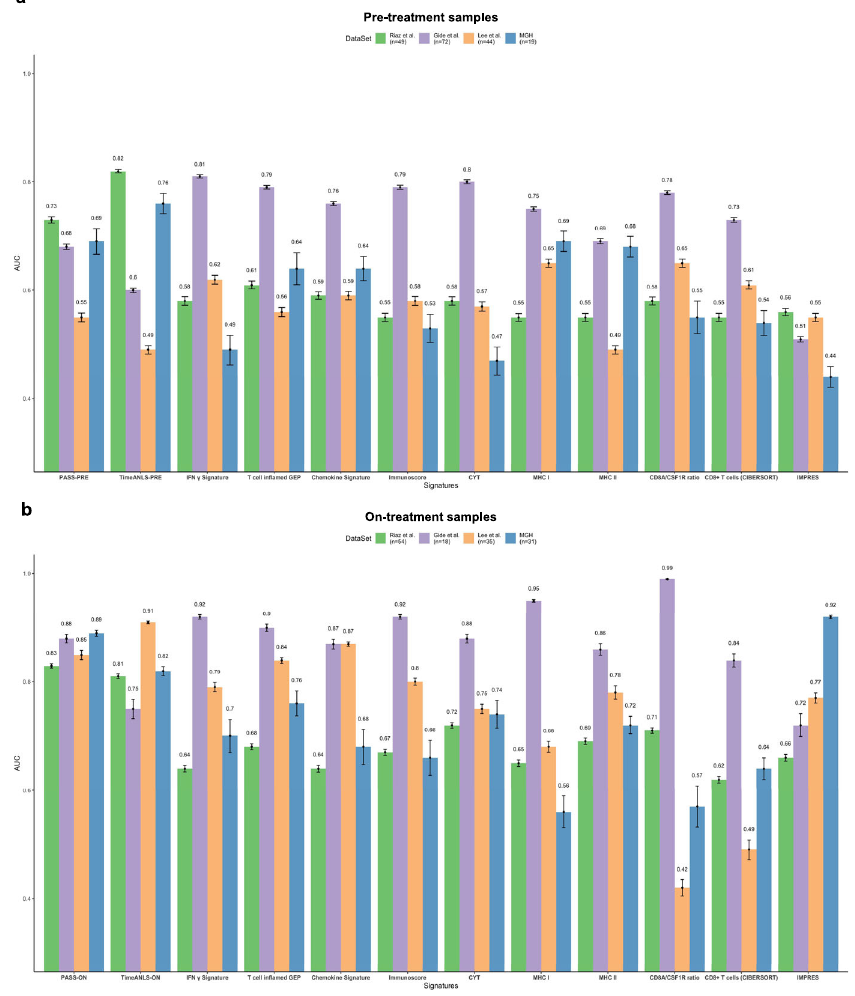
Fig. 7 The comparison of pathway-based super signatures with existing signatures. a The performance of pathway-based super signature (PASS-PRE) and time-response interaction pathway-based super signatures for pre-treatment samples (TimeANLS-PRE) in comparison with publicly existing signatures. b The performance of pathway-based super signature (PASS-ON) and time-response interaction pathway-based super signatures for on- treatment samples (TimeANLS-ON) with existing signatures. Each cohort ’ s sample number were showed in the legend. The mean value and standard deviation of AUCs were showed as error bar. Source data are provided as a Source Data fi